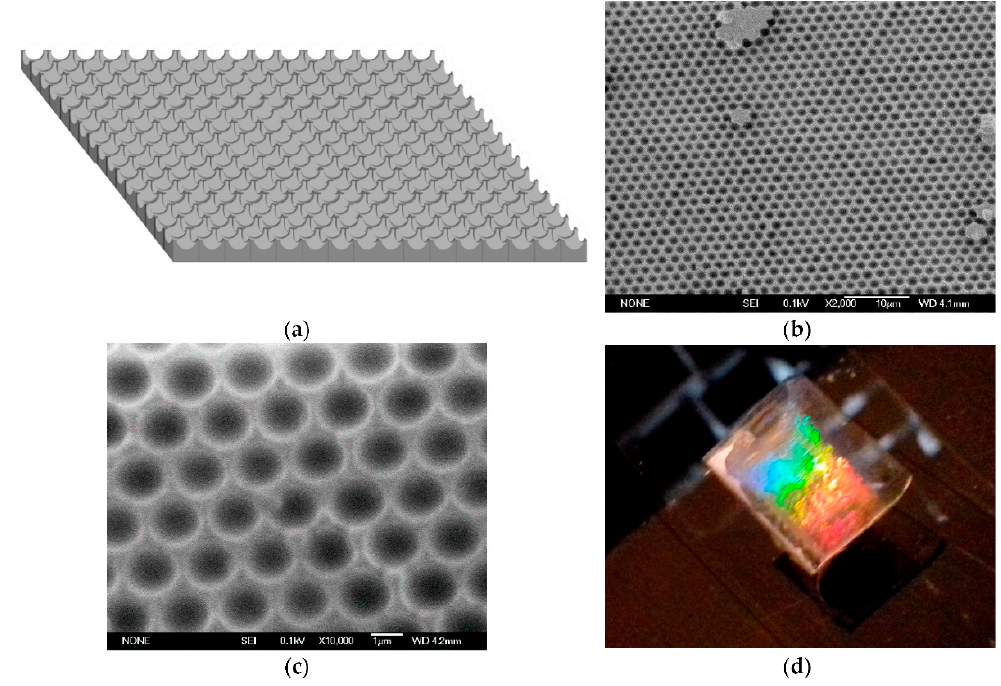
Figure 12. ( a ) Sketch of the concave structure obtained via soft lithography (not in scale). ( b ) Scanning electron microscopy (SEM) surface image of PDMS inverse colloidal crystal. ( c ) SEM detail of the ordered hexagonal array. The bar corresponds to 1 μ m. ( d ) Diffracted light from the hexagonal array of voids on transparent elastomeric substrate. Reproduced from [108] under CC BY 4.0 License.